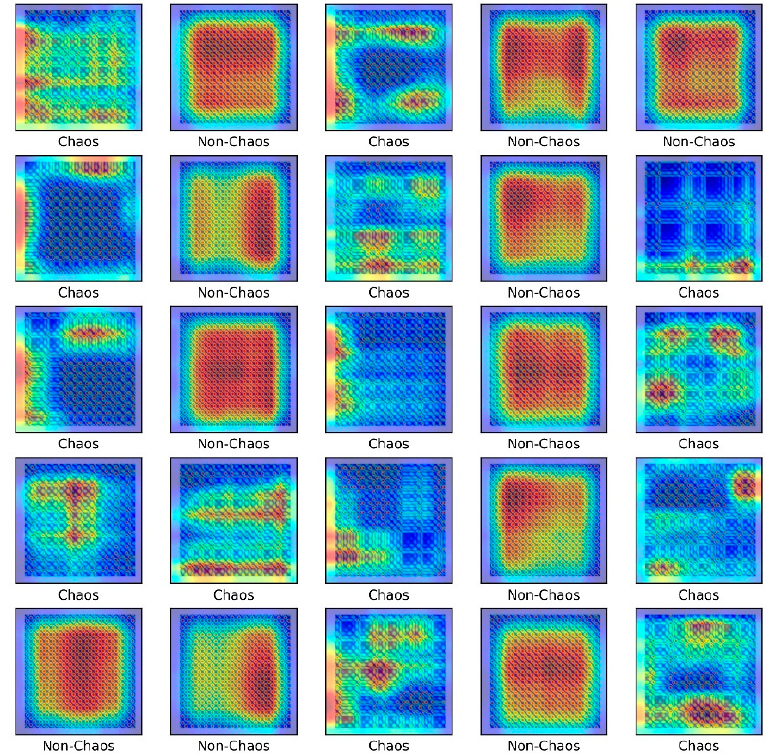
Figure 10. Class activation mapping for the Rossler model.